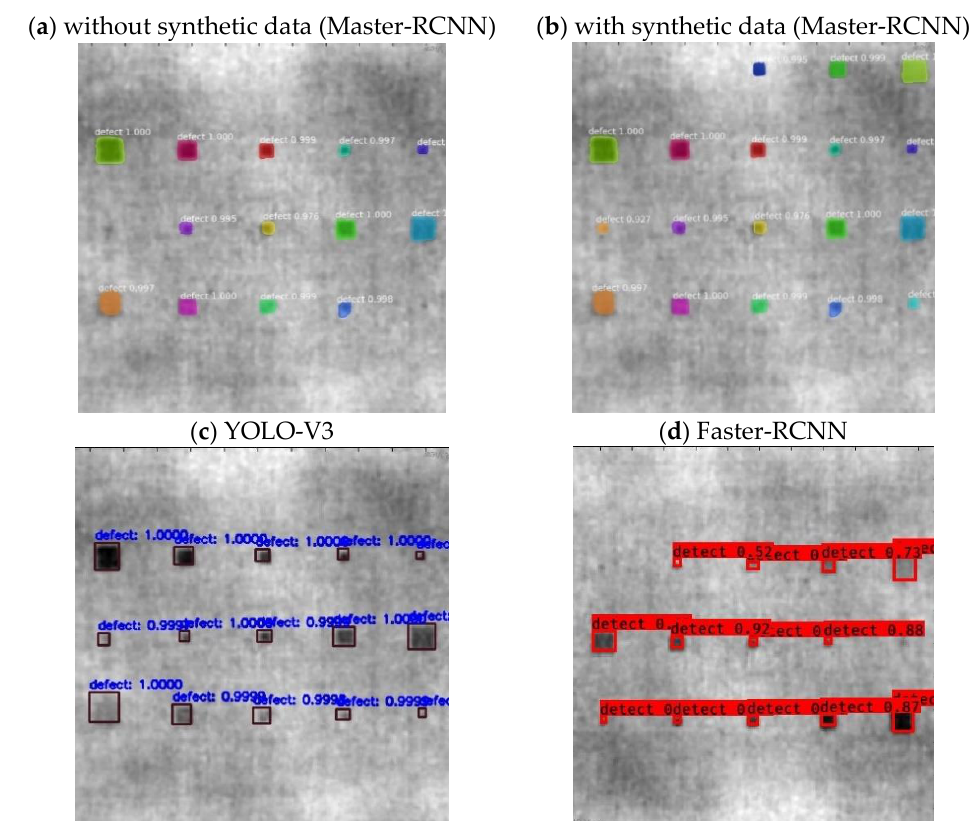
Figure 13. Detection results on a reprehensive CFRP specimen provided by different objective detection algorithms or scenarios ( a ) Master-RCNN without synthetic data; ( b ) Master-RCNN with synthetic data; ( c )YOLO-V3; ( d ) Faster-RCNN.